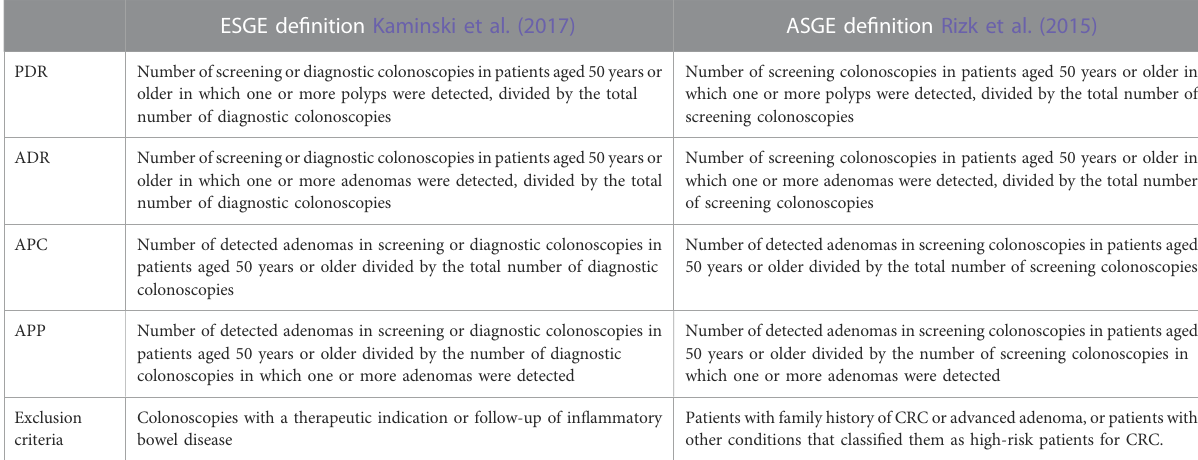
TABLE 1 ESGE and ASGE de fi nitions of quality indicators.